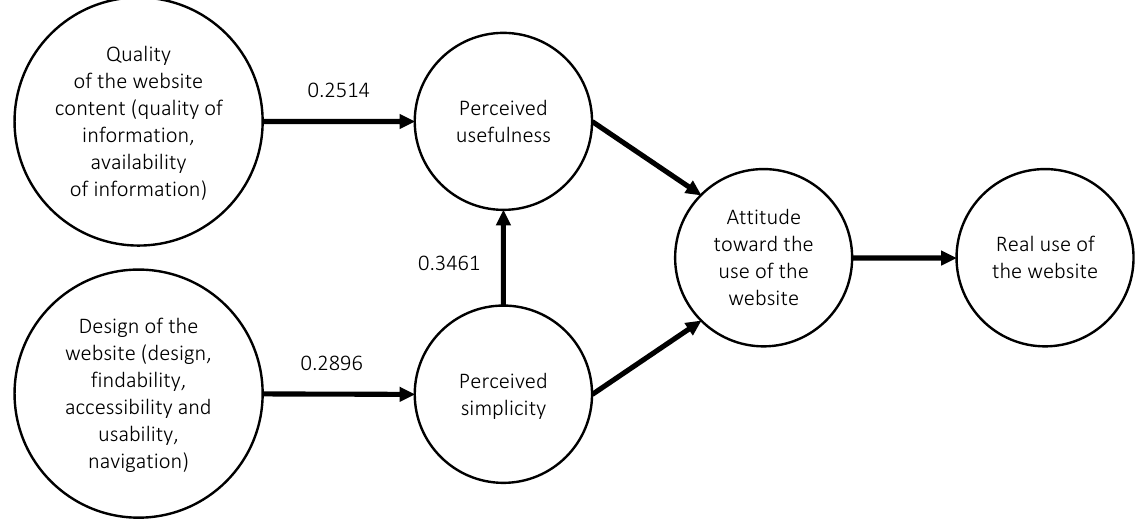
Figure 5. Final model of user Table 7. Statistical evaluation